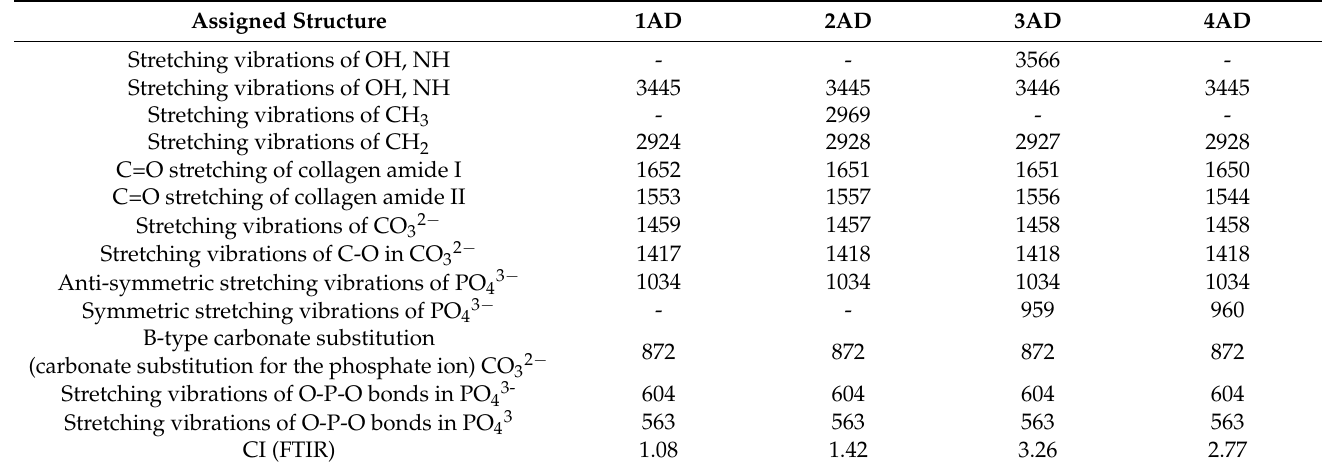
Table 1. Frequencies of the characteristic FTIR bands of different types of teeth.